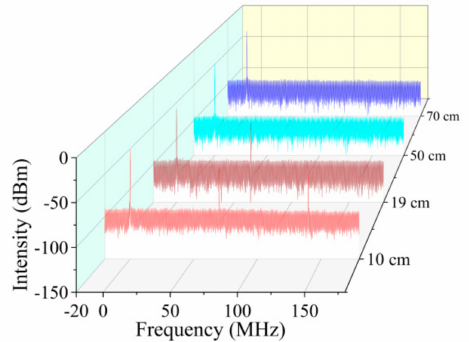
Figure 6. Beating spectra at RF when the distance between the grating and the right fiber end-face increases. The pump power is fixed at 4.5